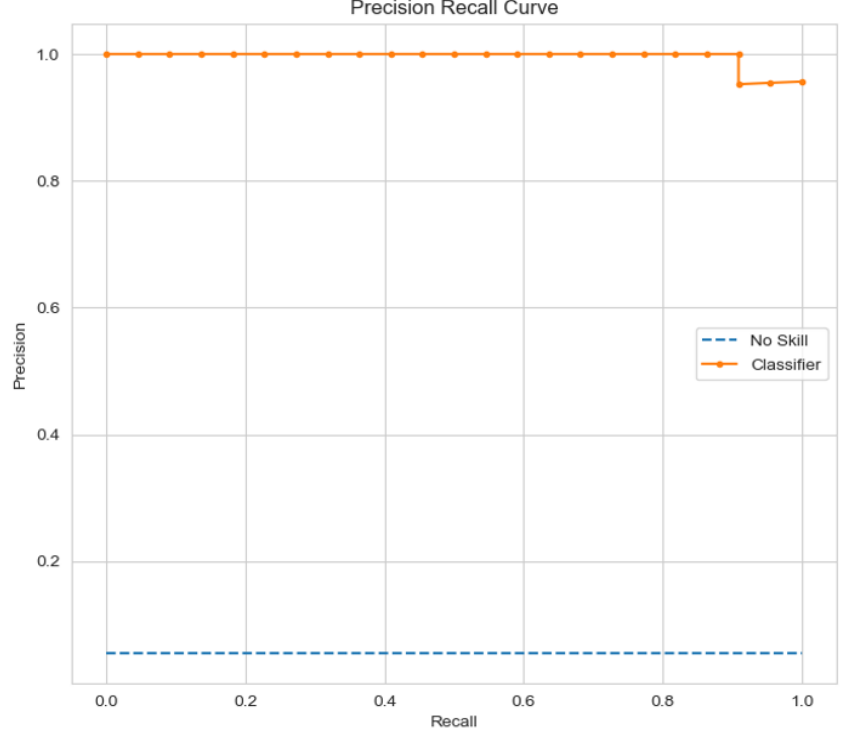
Figure 6. The precision-recall graph.